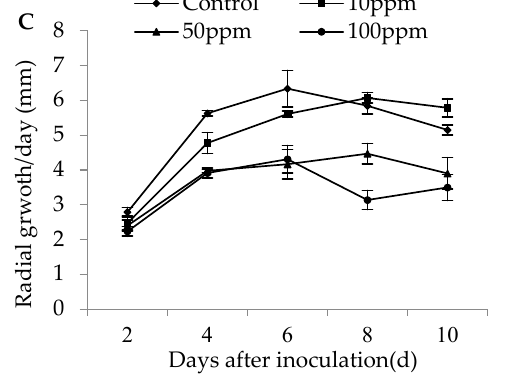
Figure 1. Radial growth rate (mm / day ± SE) of M. flavoviride on SDA added with three insecticides: Figure 1 . Radial growth rate (mm/day ± SE) of M. flavoviride on SDA added with three insecticides: ( A ) 10, 50, and 100 ppm Imidacloprid; ( B ) 10, 50, and 100 ppm Buprofezin; and ( C ) 10, 50, (A) 10, 50, and 100 ppm Imidacloprid; (B) 10, 50, and 100 ppm Buprofezin; and (C) 10, 50, and 100 and 100 ppm Abamectin. Insects 2020 , 11 , 93 ppm Abamectin.